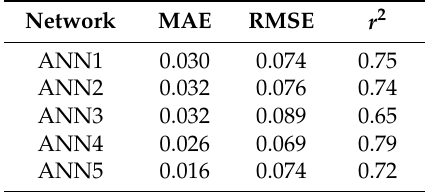
Table 5. Statistical indicators of ANN performance in simulating water retention.